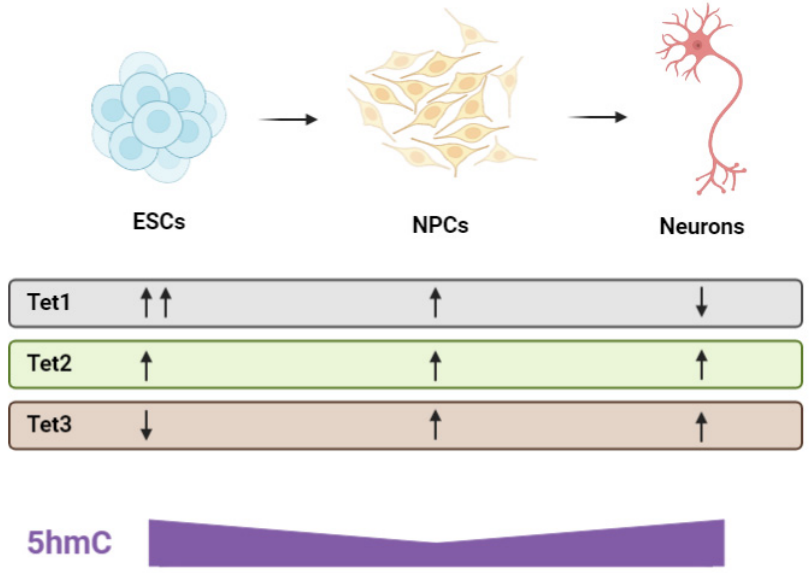
Figure 4. Schematic of TET Enzyme Expression and Corresponding 5hmC Levels during Neuro- genesis. The three Tet enzymes have distinct and important roles in neurodevelopment. Tet1 is highly expressed in embryonic stem cells (ESCs) where it regulates the expression of pluripotency related genes. 5hmC levels in ESCs are correspondingly elevated. The expression of Tet1 decreases progressively during the ESC to neural progenitor cell (NPC) and NPC to neuron transition. Tet2 is basally expressed in all three cell types and is involved in controlling the balance between self-renewal and differentiation. Tet3 expression is negligible in ESCs but increases rapidly during the subsequent differentiation events, promoting the terminal differentiation of neurons. 5hmC levels are the lowest in the NPC population which reflects their partially-differentiated identity and transient state. In contrast, neurons exhibit high levels of 5hmC due to the dynamic nature of neuronal gene expression required for neuroplasticity. Figure created with Biorender.com accessed on 8 December 2021.